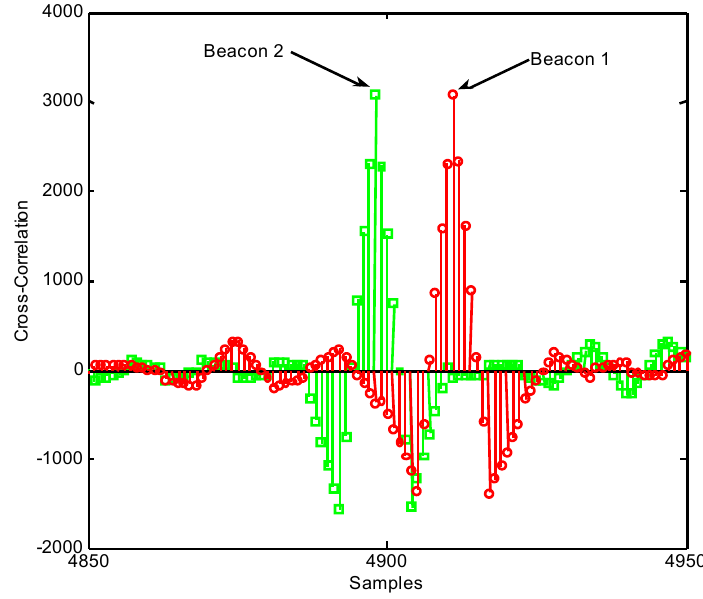
method in the time domain.